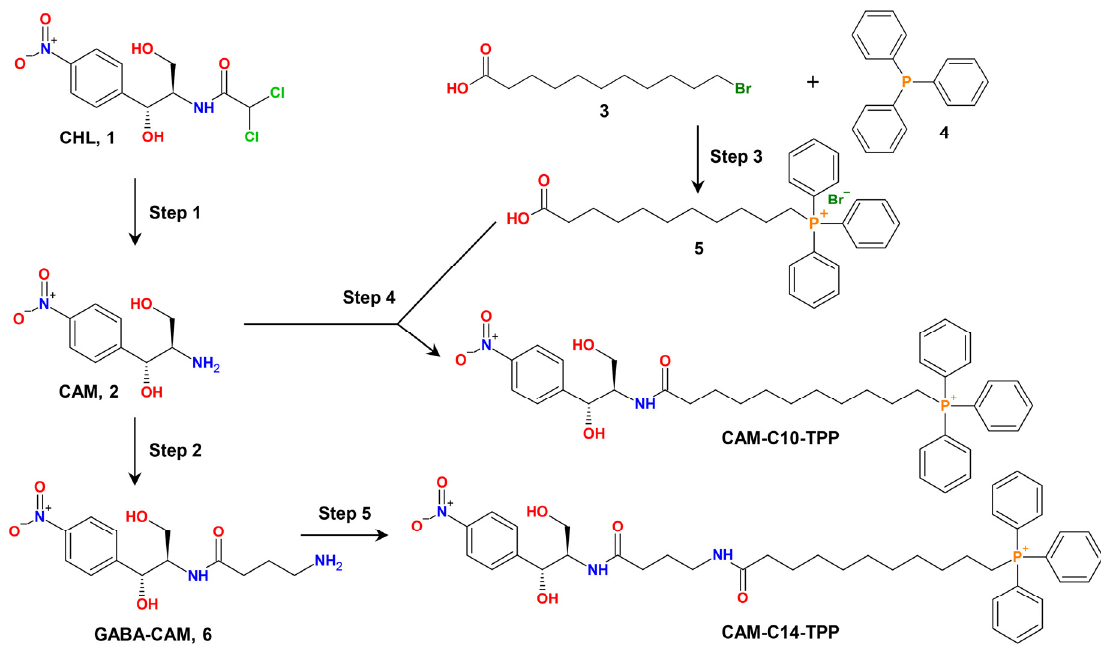
Figure 1. Scheme of the chemical synthesis of triphenylphosphonium (TPP) analogs of CHL: CAM-C10-TPP and CAM-C14- TPP. Step 1: 1M hydrochloric acid (HCl) at 100 ◦ C for 2 h. Step 2: (1) Boc-GABA-OSu, dimethylformamide (DMF), and diisopropylethylamine (DIPEA) at 25 ◦ C for 24 h; and (2) trifluoroacetic acid (TFA) at 25 ◦ C for 30 min. Step 3: benzene at 85 ◦ C for 12 h. Step 4: (1) 5 , 1-hydroxysuccinimide (HOSu), N,N (cid:48) -dicyclohexylcarbodiimide (DCC), and dichloromethane (CH 2 Cl 2 ) at 0 ◦ C for 2 h, then overnight at RT; (2) 2 , DIPEA, DMF, and stirring at RT for 5 h, then overnight at 4 ◦ C. Step 5: (1) 5 , HOSu, DCC, and dichloromethane (CH 2 Cl 2 ) at 0 ◦ C for 2 h, then overnight at RT; (2) 6 , DIPEA, DMF, and stirring at RT for 5